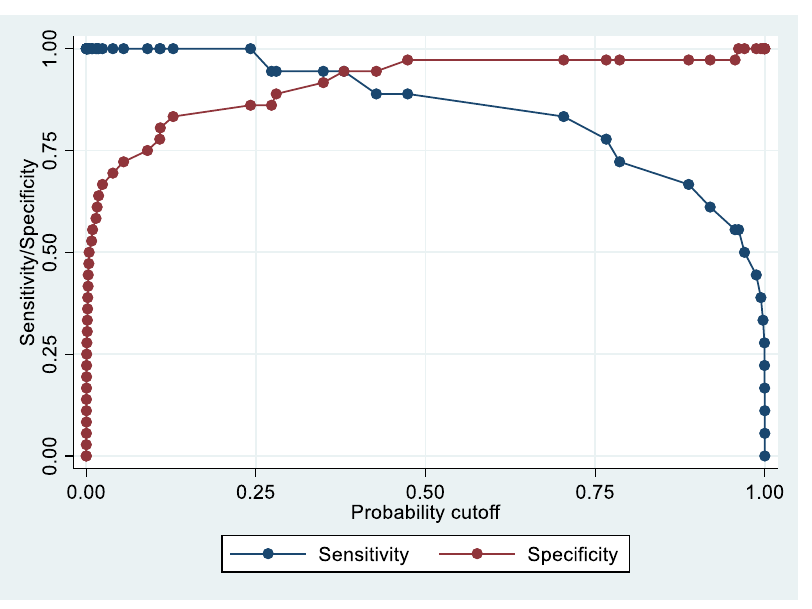
Table 6. Final multivariate logistic regression model including only exosomes significantly associated with the outcome Stage 1 EC patients vs. controls. Table 7. Final Stage 1 EC patients vs. controls model: sensitivity/specificity plot for the resulting multivariate logistic regression model for sensitivity levels higher than specificity levels.